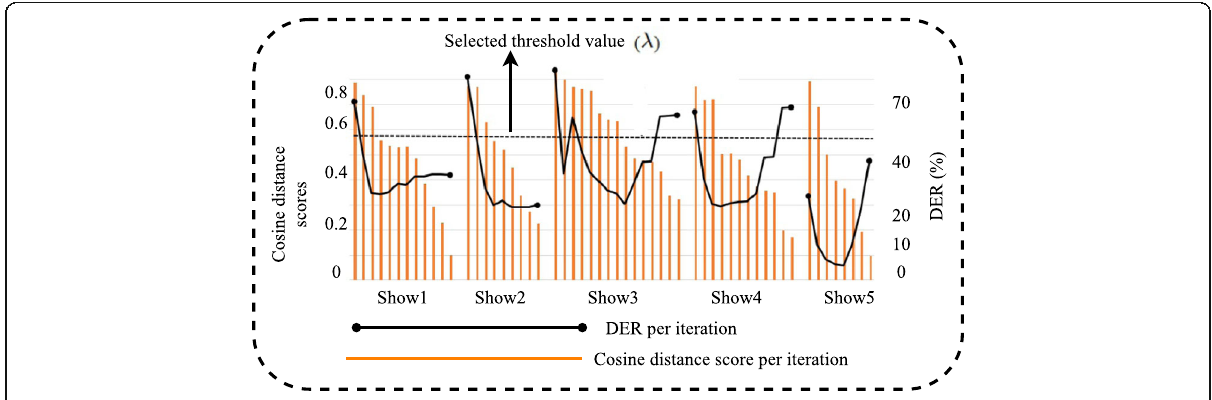
Fig. 6 DER and cosine-distance score per iteration for selected shows from the development